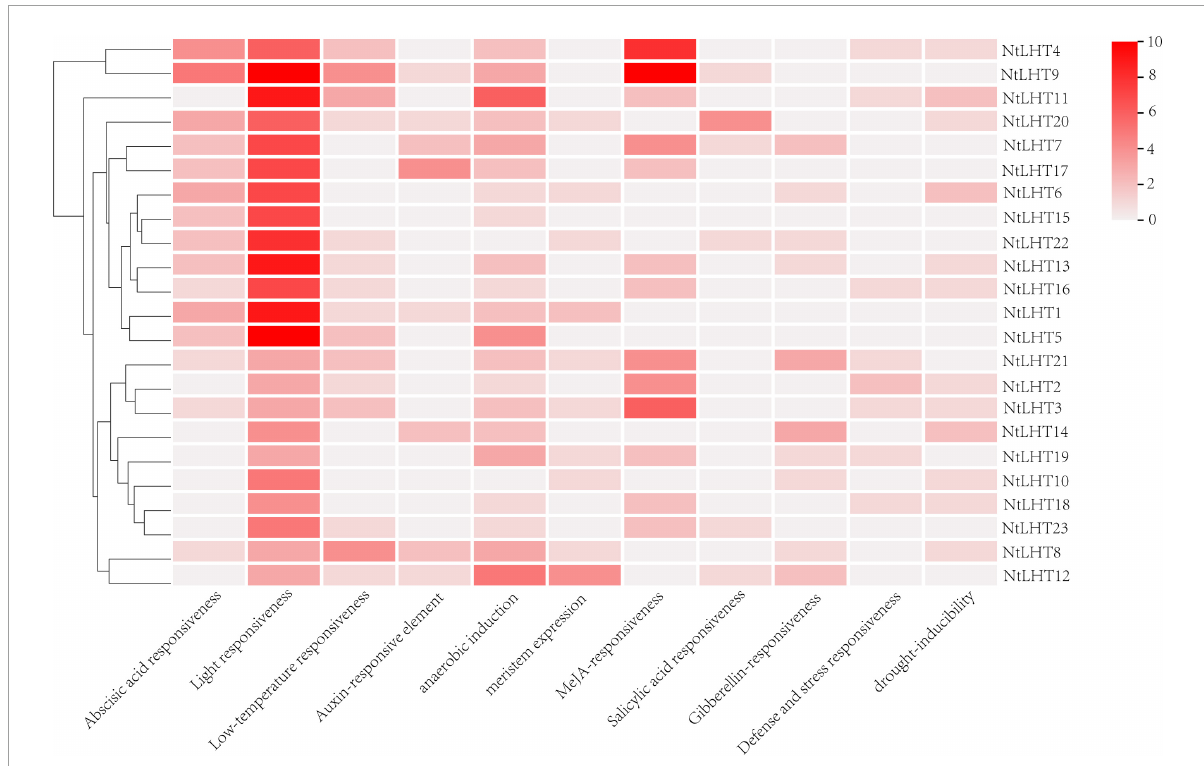
FIGURE6 Cis -element analysis in the NtLHT genes promoter. The color represent the numbers of cis -element in NtLHT genes promoter.